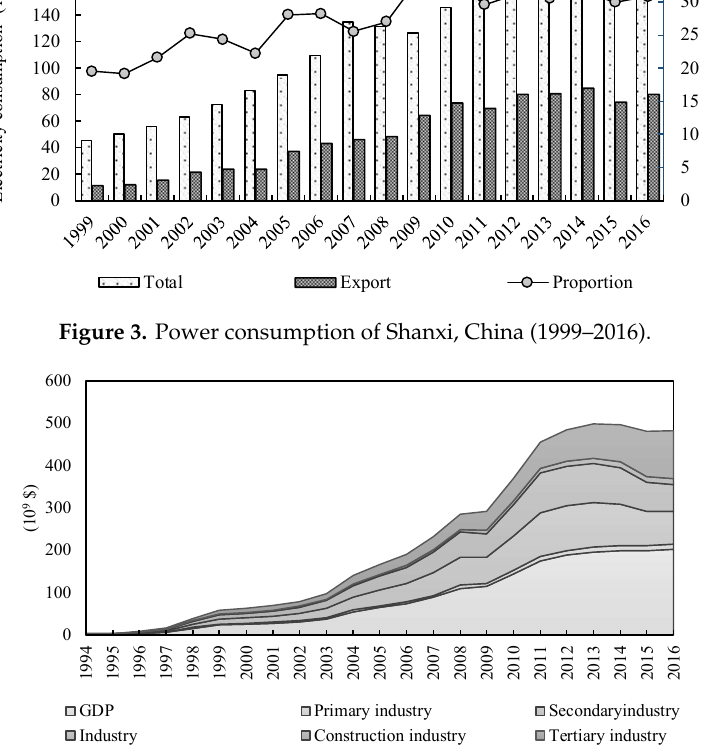
Figure 4. The relevant economic parameters for electricity demand forecasting. This is assuming that emission constraints can be violated under three specified p levels ( p = 0.01, 0.05, and 0.1, known as significance levels) [6]. Figure 5 reveals the economic cost under three